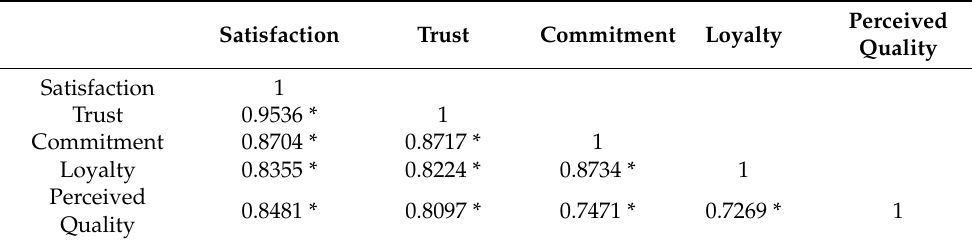
Table 2. The correlation matrix between perceived quality ≥ satisfaction ≥ trust ≥ commitment ≥ loyalty.